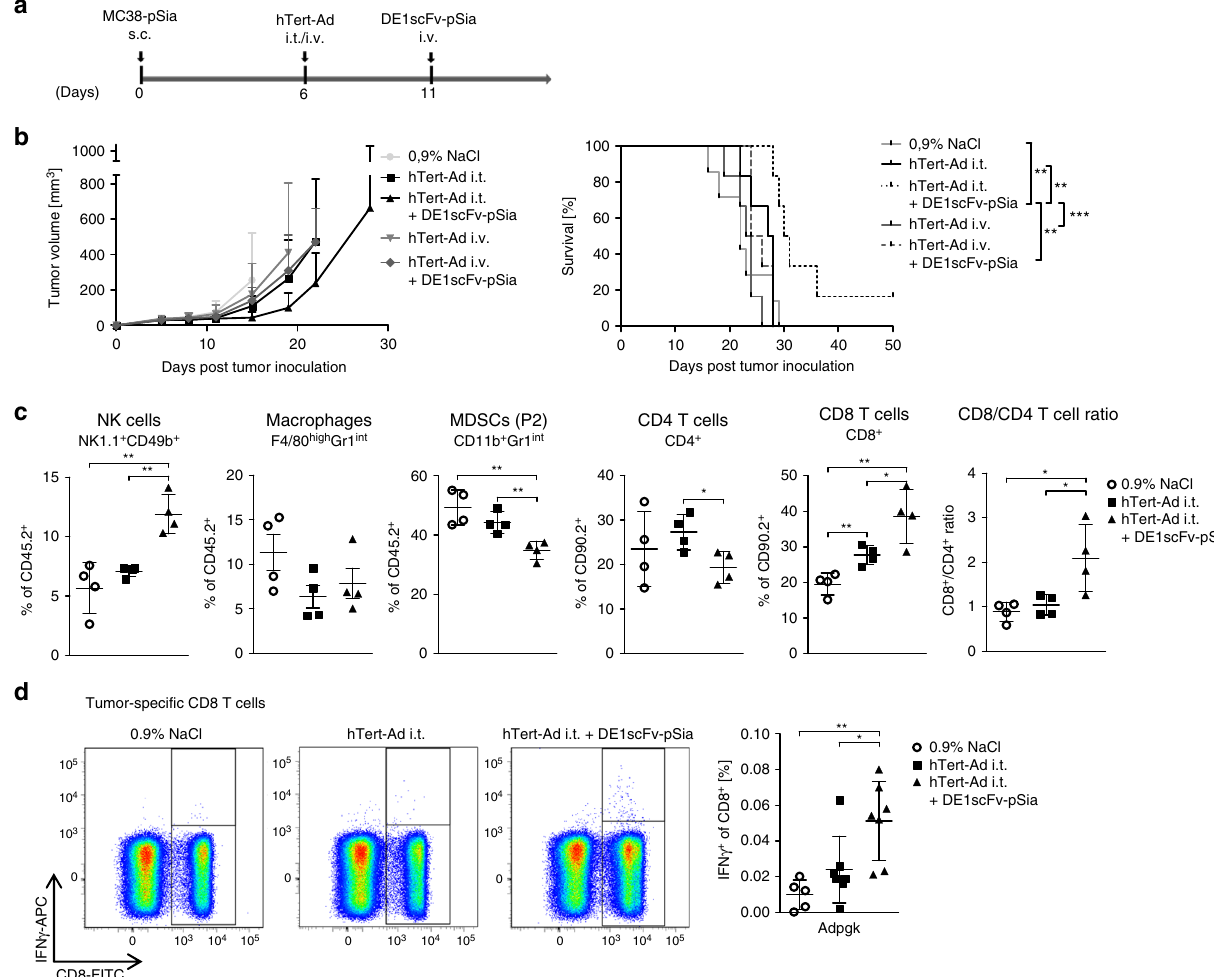
Fig. 5 Ab-retargeting after intratumor application of an oncolytic adenovirus leads to improved survival. a Subcutaneous MC38-pSia tumors were established in Ad5-naive mice. After tumor formation, animals received a single application of the oncolytic adenovirus hTert-Ad (by either intratumor or intravenous application) followed by a single i.v. administration of DE1scFv-pSia as shown in the treatment scheme. Control animals were treated by i.t. injection of saline. b Tumor development and survival were monitored (group size n = 6, except control group 0.9 % NaCl: n = 7, median survival: 0.9% NaCl 22 days; hTert-Ad i.v. 23.5 days; hTert-Ad i.t. 27.5 days; hTert-Ad i.v. + DE1scFv-pSia 25 days; hTert-Ad i.t. + DE1scFv-pSia 30.5 days). c